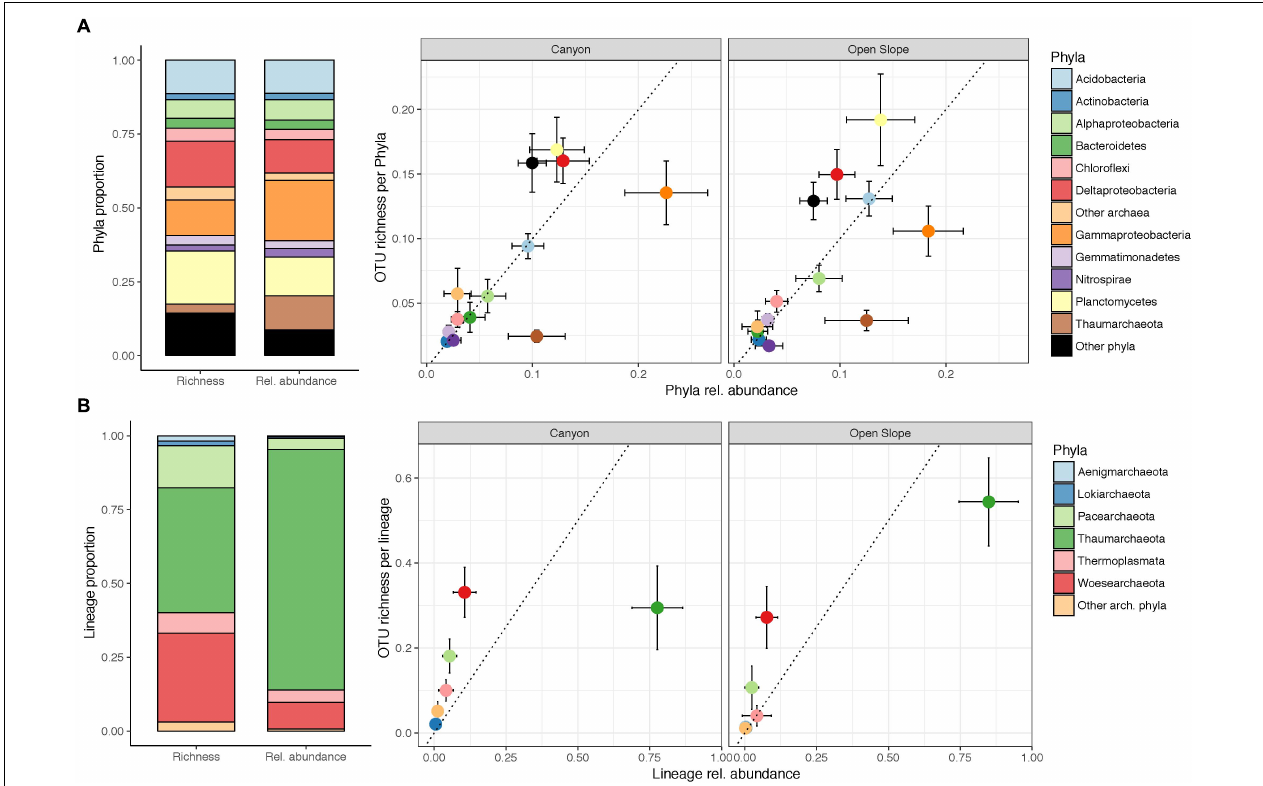
FIGURE 4 | Average microbial community profile per sample (richness and relative abundance), and phyla ratios between the proportion of richness and relative abundances per habitat (canyon and slope) based on the average number of reads per sample. Error bars indicate the standard deviation (SD). Panels indicate: (A) overall taxonomic profile and ratios and (B) archaea specific profile and